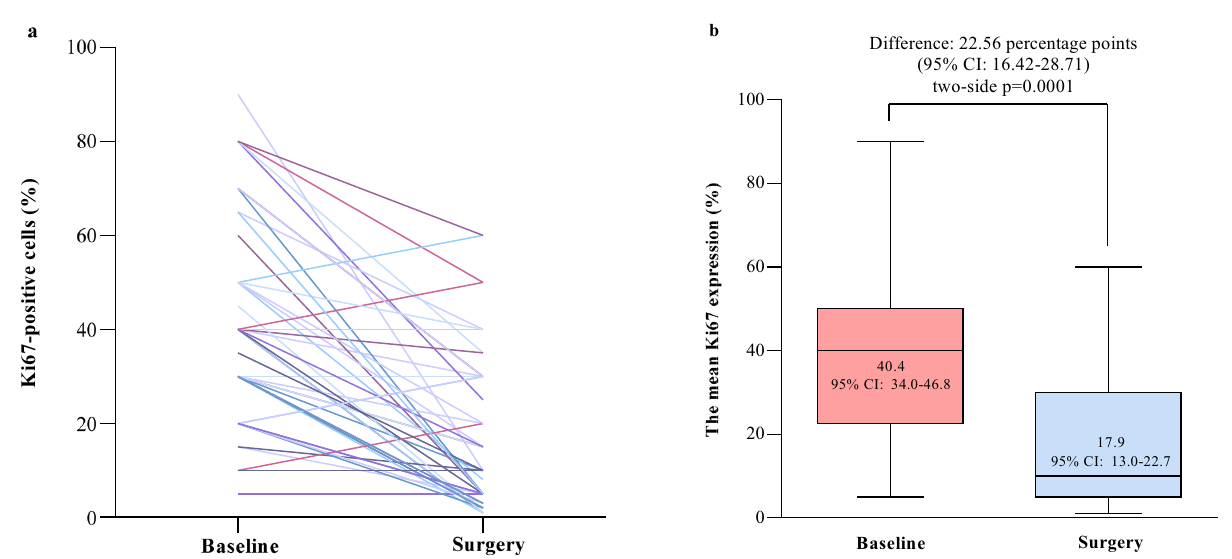
Fig. 3 | Ki-67 expression at baseline and surgery. a Individual data ( n =48). b Mean percentages of Ki-67 expressing tumor cells of each group ( n =48). Sta- tisticalanalysiswasperformedbypairedtwo-sided t -test.TheKi-67expressionin31 outof79patientswasnotassessableduetothelackofdetectabletumorcellsinthe